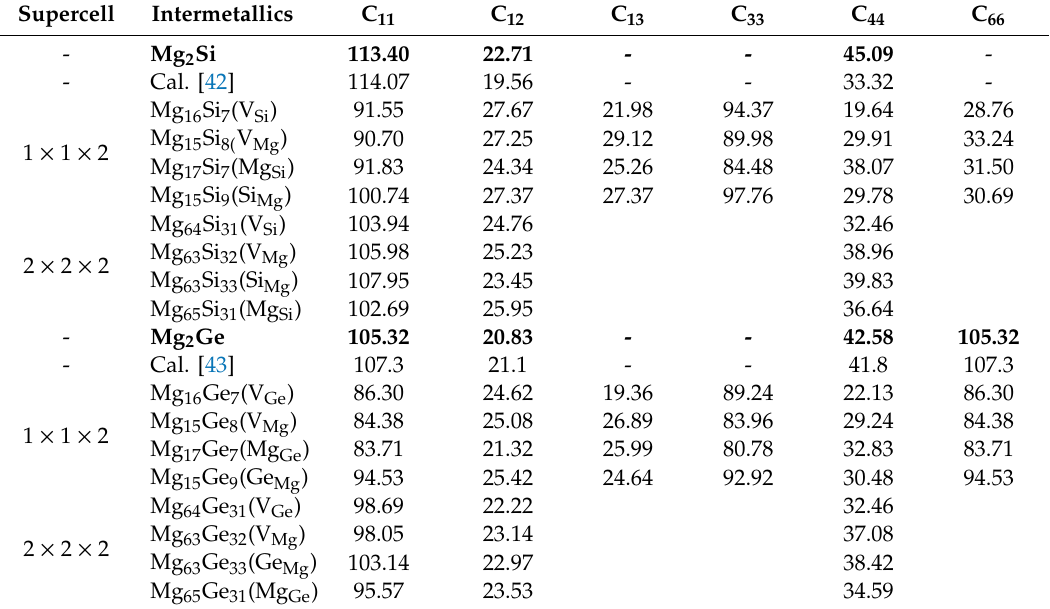
Table 5. Computed elastic constants C ij (GPa) of Mg 2 X (X = Si, Ge) with or without a point defect (a vacancy or an anti-site defect) in di ff erent